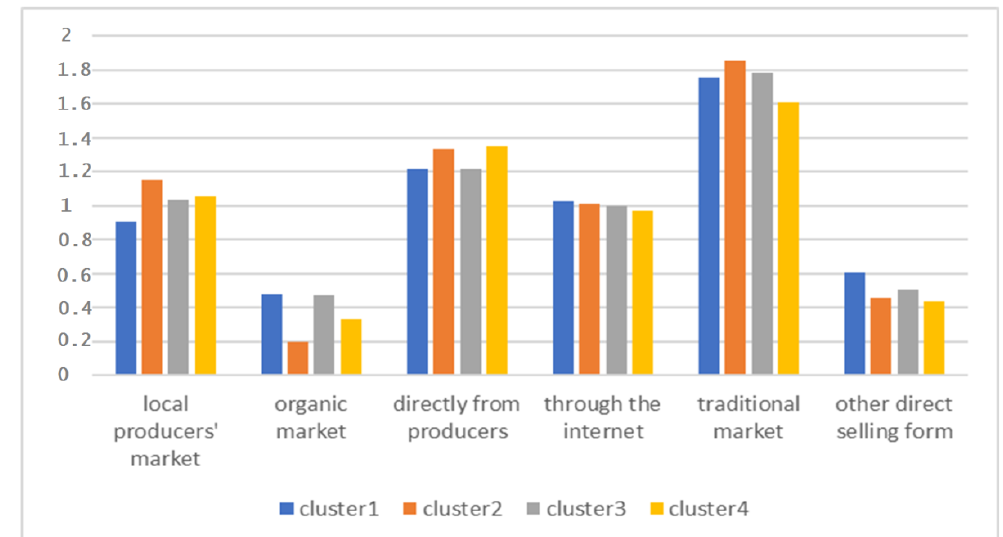
Figure 2. Channels frequently used in different segments.